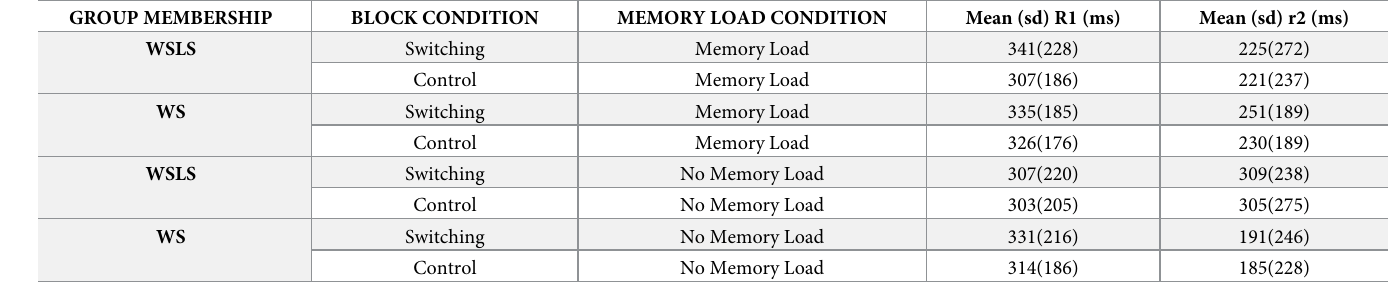
Table 2. Mean reaction times at R1 (first response) and R2 (second response) of choice task. GROUP